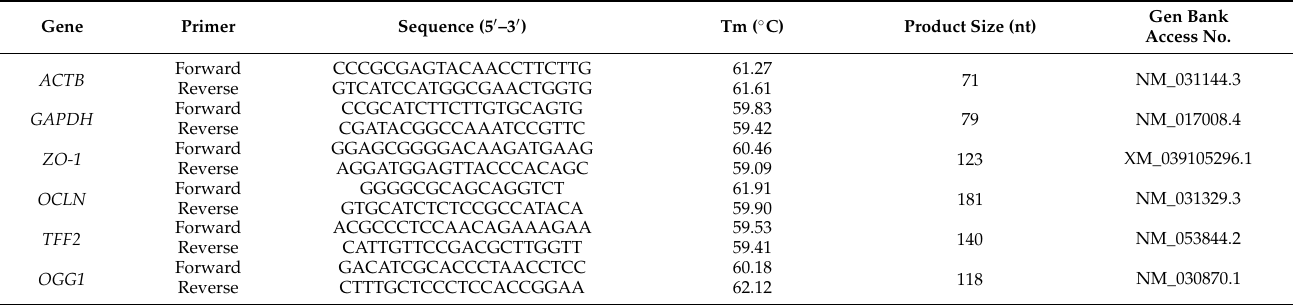
Table 2. The primer sequences for analysed